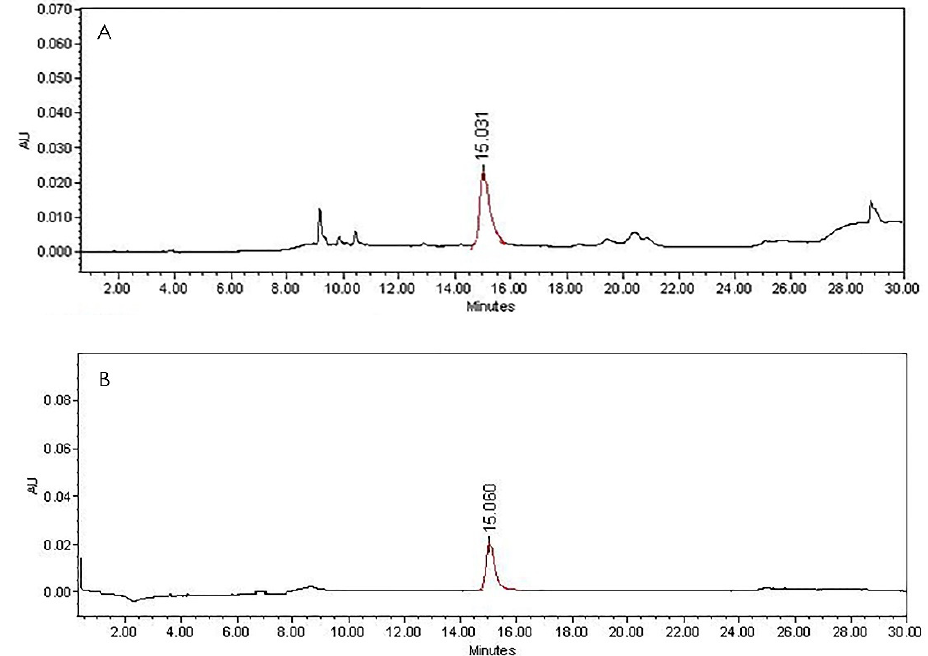
Table 2. Minimal Bactericidal Concentration of the Salix babylonica hydroalcoholic extract and fractions against Escherichia coli , Staphylococcus aureus , and Listeria monocytogenes . Treatment mg / mL